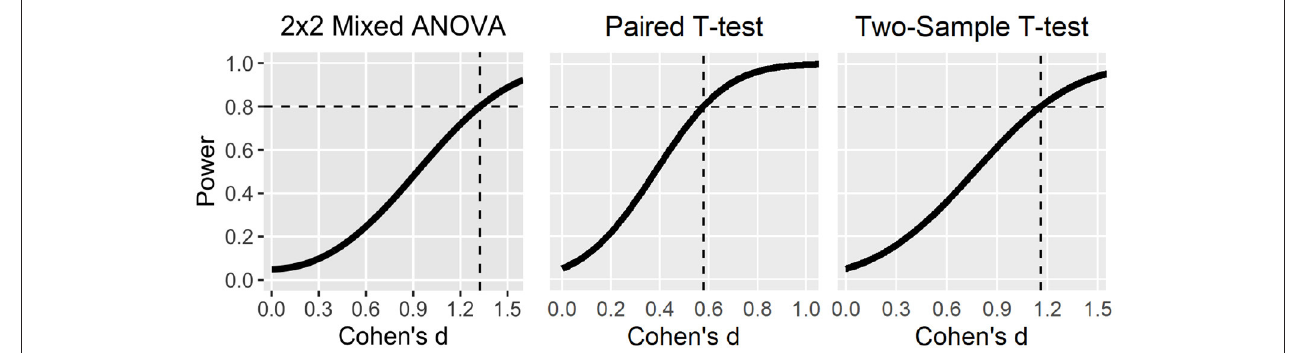
FIGURE 4 | Statistical power curves to detect different effect sizes with 20 participants (median sample size) for different statistical tests. Dashed lines indicate smallest effect sizes detectable at 80% power. Note that the power curve for the 2 × 2 mixed ANOVA was based on liberal statistical assumptions (e.g., high correlation among repeated measures, sphericity, and uncorrected p -value of 0.05).